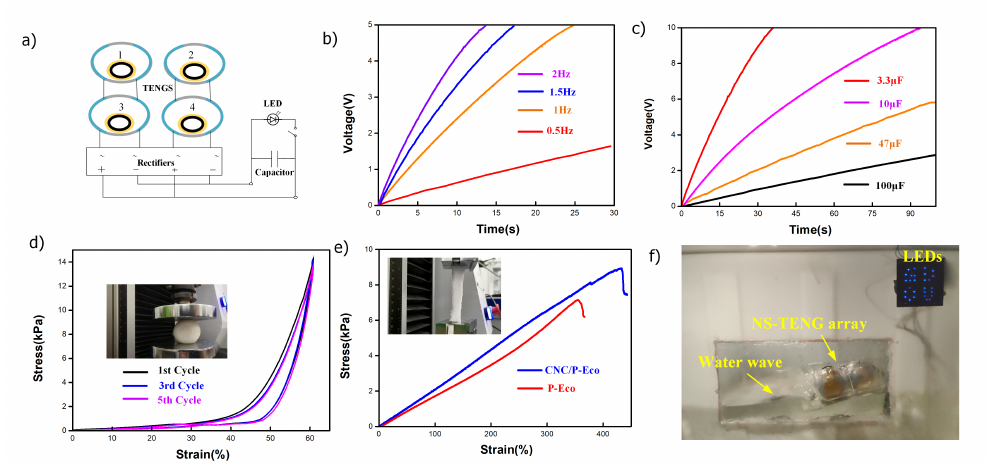
Figure 4. ( a ) Circuit diagram of the self-powered LED circuit consisting of an NS-TENG array and a capacitor; ( b ) charging of 3.3 µ F capacitors with different frequencies; ( c ) the charging curves of NS-TENG-2 at 2.0 Hz for different capacitors (3.3 µ F, 10 µ F, 47 µ F, 100 µ F) ( d , e ); the compressibility and stretchability of the NSP film; ( f ) photo of the NS-TENG array as a power source to light the “GDOU” LED pattern by water wave triggering.